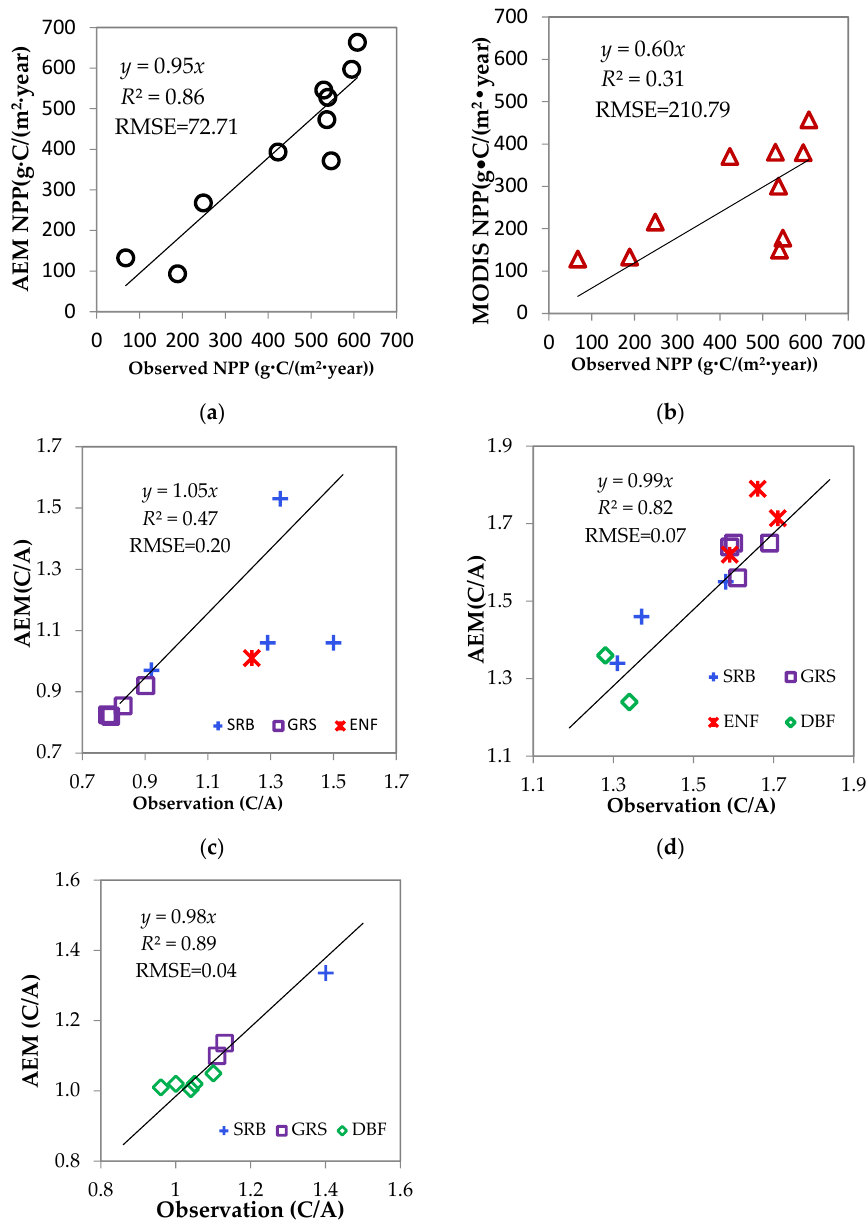
Figure 2. Additional model validation: comparing the net primary productivity (NPP) predicted by Arid Ecosystem Model (AEM) ( a ) and Moderate Resolution Imaging Spectroradiometer (MODIS) data against the field observations in the semiarid ecosystems of ASA-China ( b ), and evaluating AEM’s performance in predicting the responses of plant functional types (PFTs) to changes in temperature ( c ), atmospheric CO 2 ( d ), and precipitation ( e ). The PFTs’ responses (C/A) are quantified as the ratios between the NPP under climate/CO 2 change treatments (C) and the NPP under ambient climate/CO 2 (A). GRS: grassland; SRB: shrubland; ENF: evergreen needleleaf forest; DBF: deciduous broadleaf